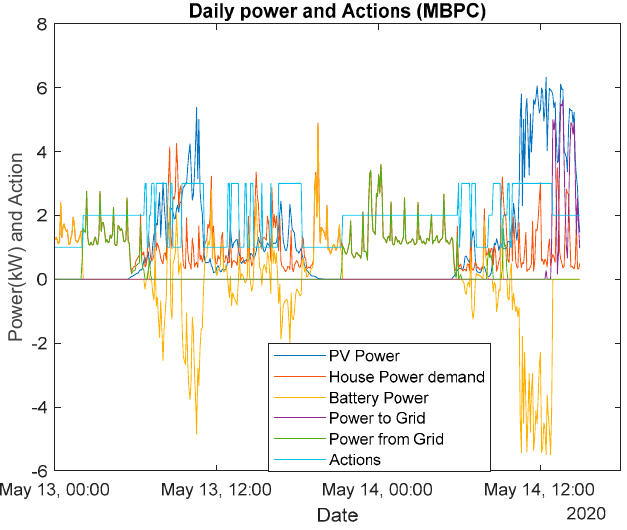
Figure 17. Different power signals—MBPC control (cloudy day).